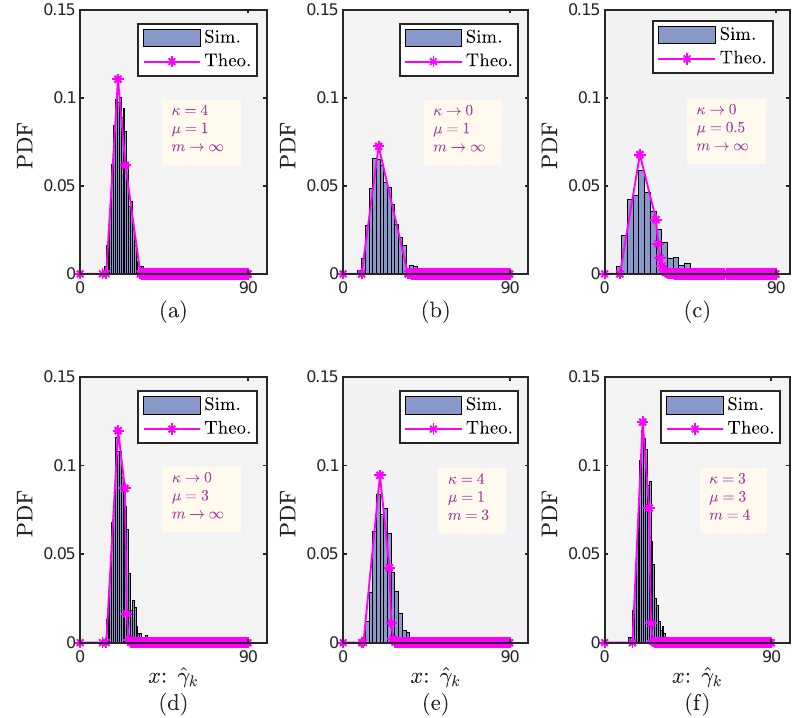
Figure 4. PDFs of the PPSNR for CF mMIMO system. ( a ) under the Rician fading channel; ( b ) under the Rayleigh fading channel; ( c ) under the One-sided fading channel; ( d ) under the Nakagami- m fading channel; ( e ) under the Rician shadwoed fading channel; ( f ) under the κ – µ shadowed fading